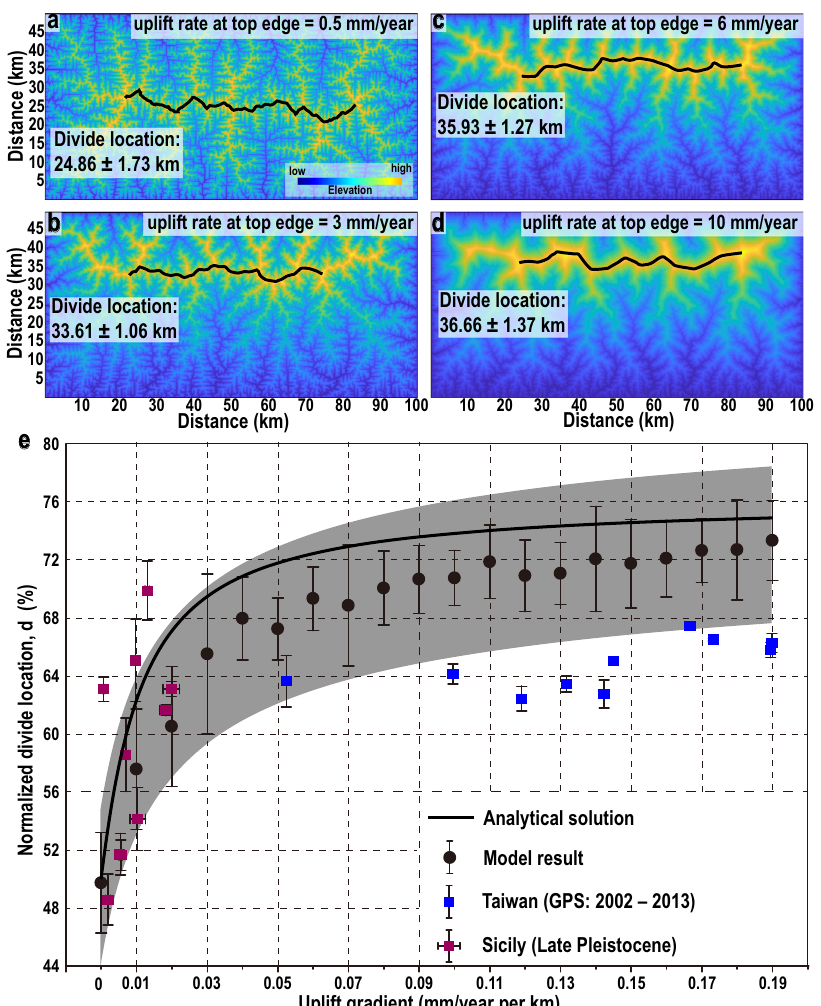
Fig. 2 Relationship between uplift gradient and normalised divide location. a – d Selected model results of divide position in response to asymmetric uplift. Topographies of asymmetric mountain range generated by the TopoToolbox Landscape Evolution Model (TTLEM 40 ) in response to a linear gradient in uplift rate from 0.5 mm/year at the bottom edge to a 0.5 mm/ year, b 3 mm/year, c 6 mm/year, and d 10 mm/ year at the top edge. Black lines are the main drainage divides of mountain ranges. A run time of 300 Myr (million years) is suf fi cient to attain steady state from the initial topography in all cases (Supplementary Fig. 6). e Relationship between uplift gradient and steady-state divide location. The data points denote the mean values with one standard deviation. Each data point of Southern Taiwan and Northeastern Sicily is calculated from three values (see “ Methods ” ). For numerical simulation, 2000 – 3000 values are used to calculate divide location, depending on the length of the main drainage divide. Grey shading represents the 95% con fi dence range of the model results. Uplift rates of Northeastern Sicily integrated since the Late Pleistocene (~125,000 years) are calculated from data in ref. 47 . Uplift rates of Southern Taiwan are calculated from decadal-scale GPS data. Source data are provided as a Source Data fi